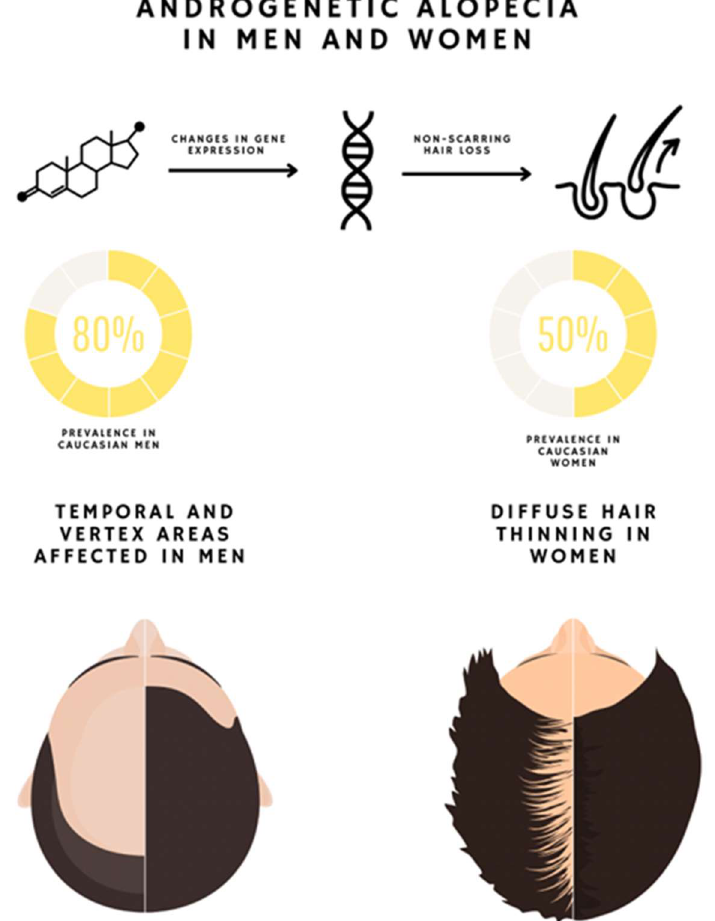
Figure 1. Androgenic alopecia in men and women.